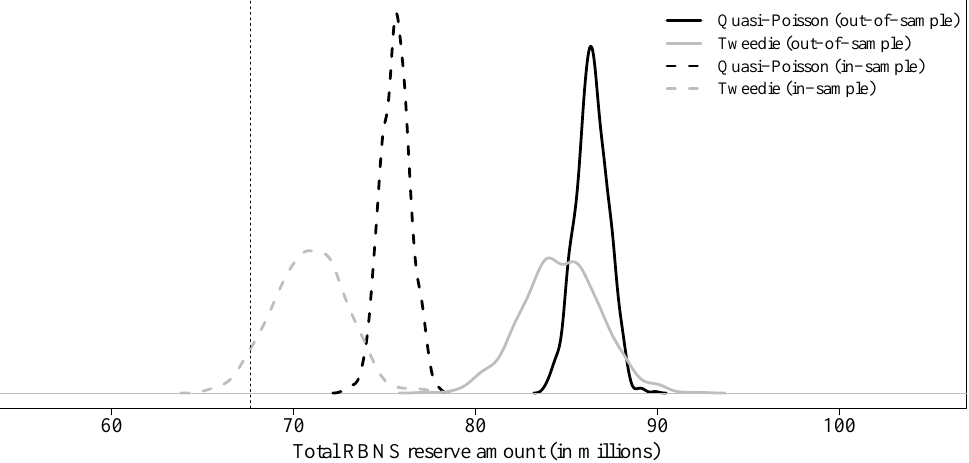
Figure 4. Predictive distributions (RBNS) for individual GLM with covariates.